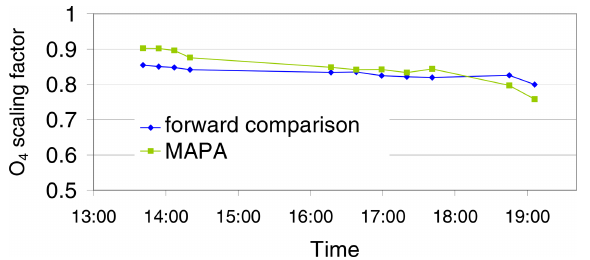
Figure 7. Scaling factors derived from the direct comparison be- tween the measured and simulated O 4 dSCDs (blue) and from the MAPA profile inversion (green) for all elevation sequences shown in Figs. 6 and A12. Many of the measurements of the two last eleva- tion sequences are affected by clouds. Note that for the last elevation sequence, the AOD used in the forward model has large uncertain- ties; see Sect.